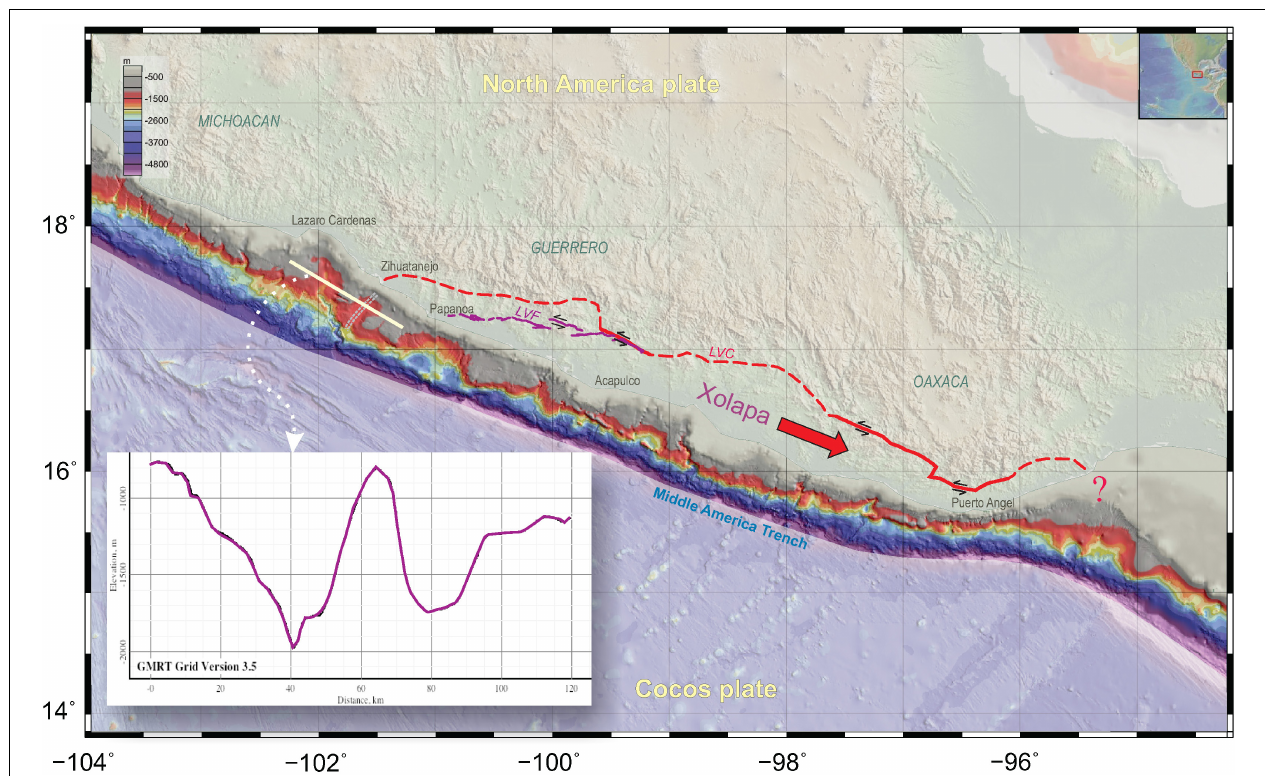
FIGURE 7 | Topographic and bathymetry map [The Global Multi-Resolution Topography synthesis, GMRT (Ryan et al., 2009)], exposing a continental margin in Southern Mexico. The 750–1,600 m depth range is in red. A bathymetric profile at ∼ 1,500 m from Lazaro Cardenas city to Papanoa is shown in the bottom inlet. Two prominent depressions have a total average width of ∼ 40 km (at 1,500 km depth). The red arrow indicates the Xolapa sliver southeast motion. Local concave shape of the continental margin is seen in the area of the Tehuantepec ridge. The red line is a trace of the LVC fault system (Tolson, 2005). Magenta lines in the coastal area show the LVF fault discovered by Gaidzik et al.